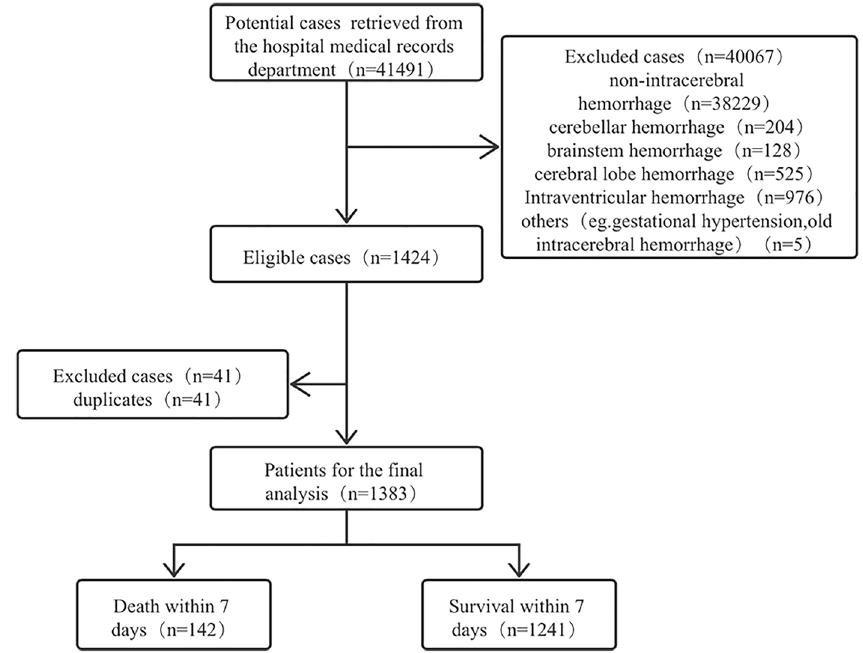
Figure 2. Flow diagram of study recruitment and